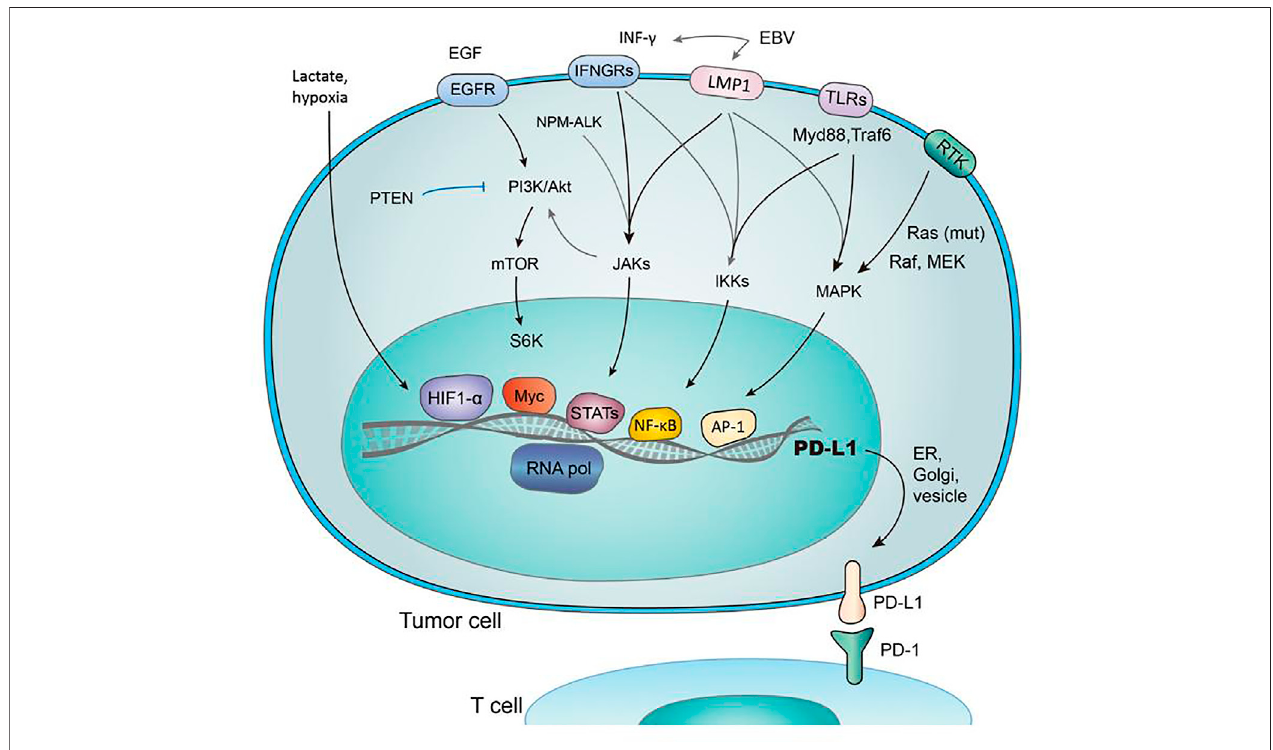
FIGURE 1 | Regulation of PD-1/PD-L1 expression by several pathways. The fi gure were adapted and reproduced from reference (Wang et al., 2018b) under the Creative Commons Attribution License (CCBY).